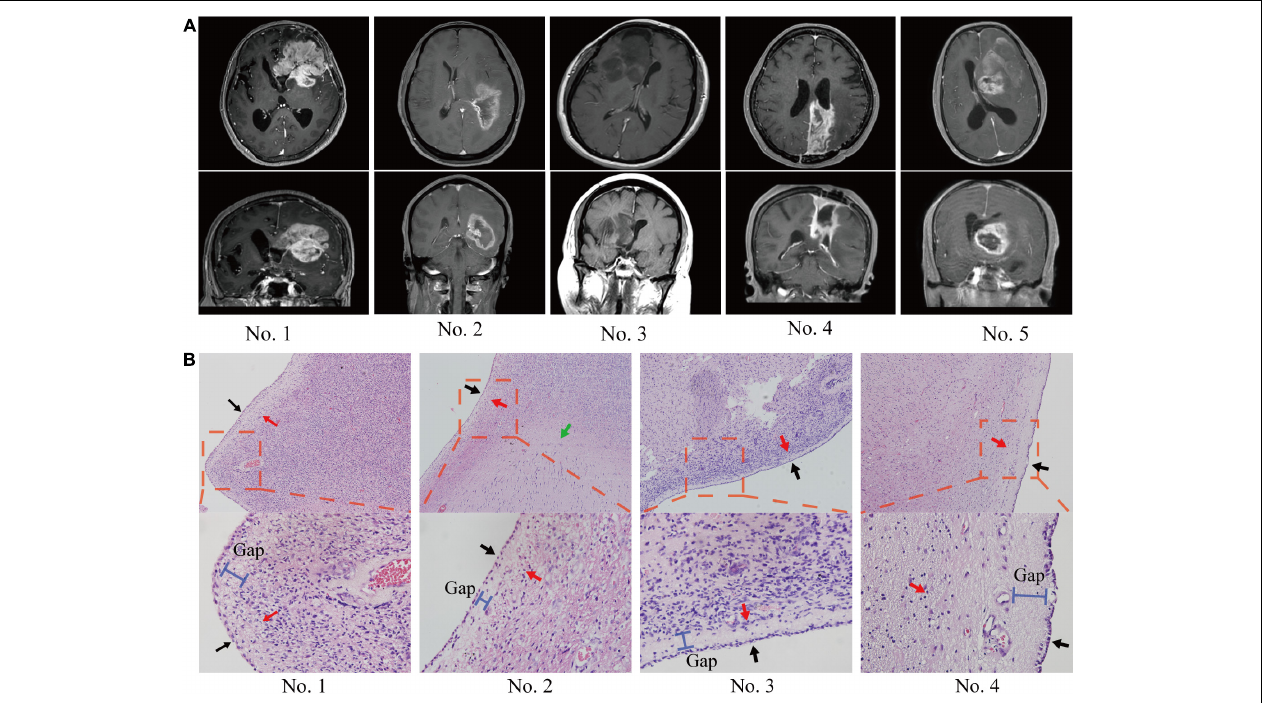
FIGURE 1 | The anatomical relationship between the tumor and SVZ/ependymal region was determined by MRI and HE staining. (A) On MRI, glioblastoma spread along the ependymal and pushed the lateral ventricle, but there was no sign of breaking through the lateral ventricle. (B) Pathological biopsy also indicated that glioblastoma cells spread along the ependymal but did not enter the lateral ventricle wall. Red arrows, tumor; black arrows, ependymal; green arrows, normal tissue; blue bar, subependymal gap.